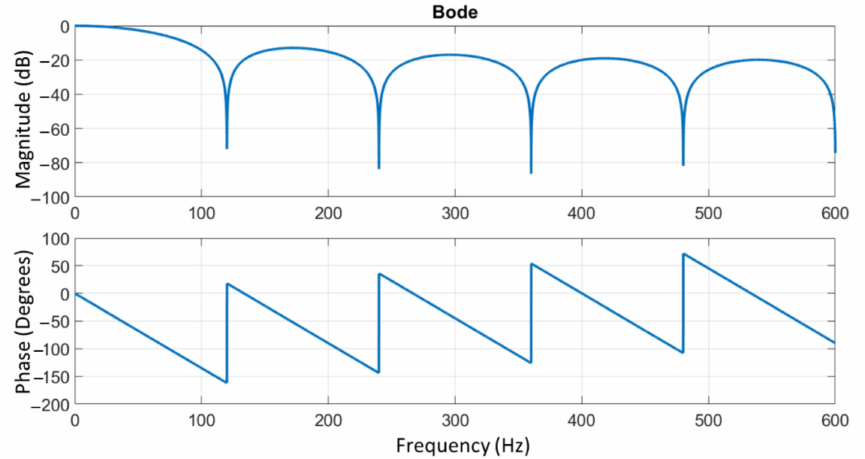
Figure 5. Bode plot—Module and phase of the MA filter for N = 10, f a = 1200 Hz, and f c = 120